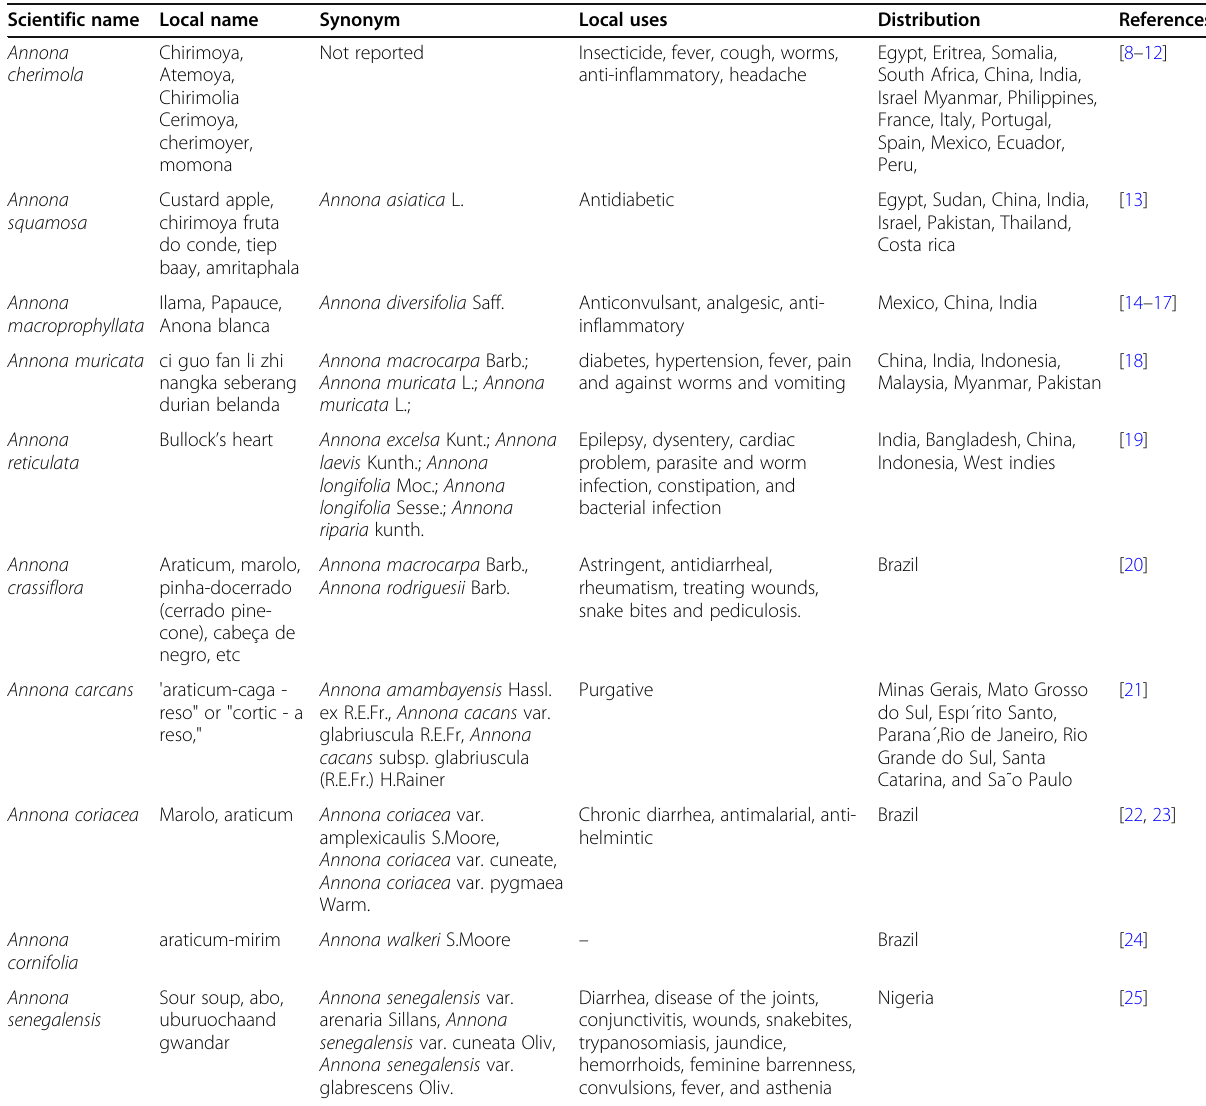
Table 1 Botanical Information of the